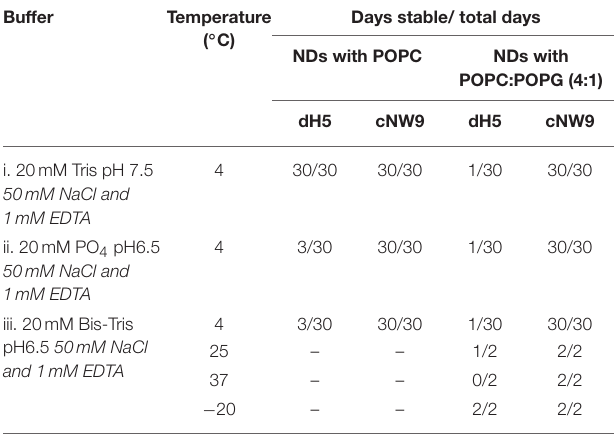
TABLE 1 | Summary of nanodisc stability under different storage conditions. ( Figure S8 ). The dH5 ND samples aggregated over time, while no degradation was observed for cNW9